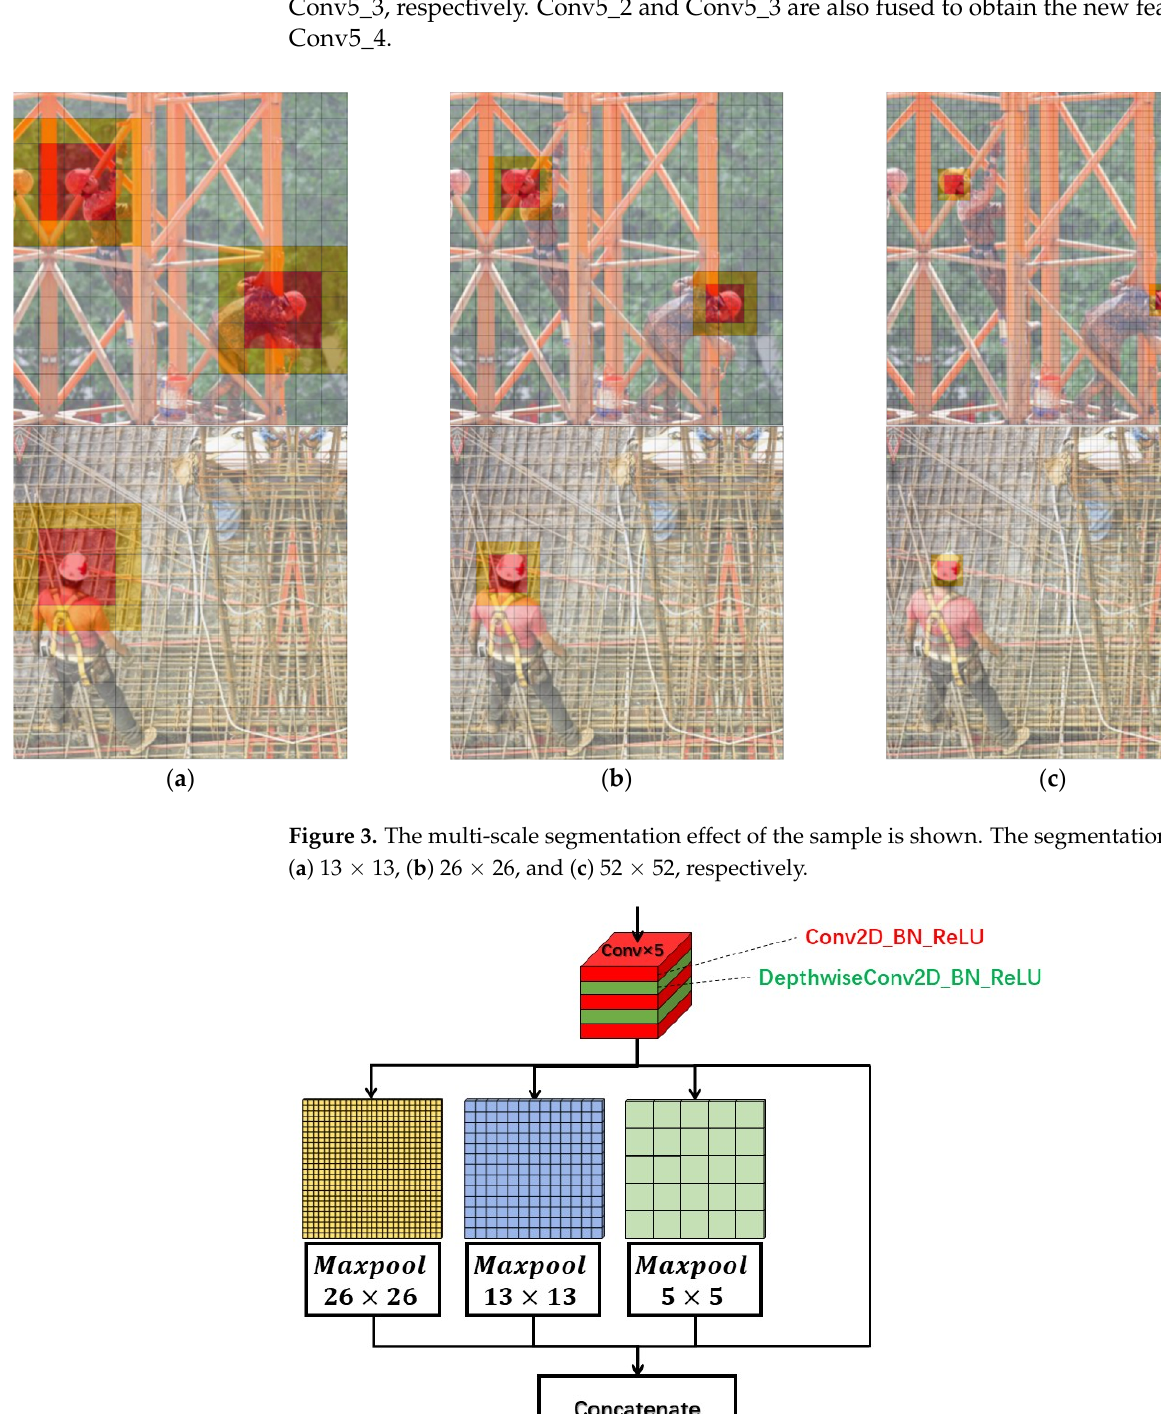
Figure 4. The structure of the Conv×5 module and spatial pyramid pooling (SPP).